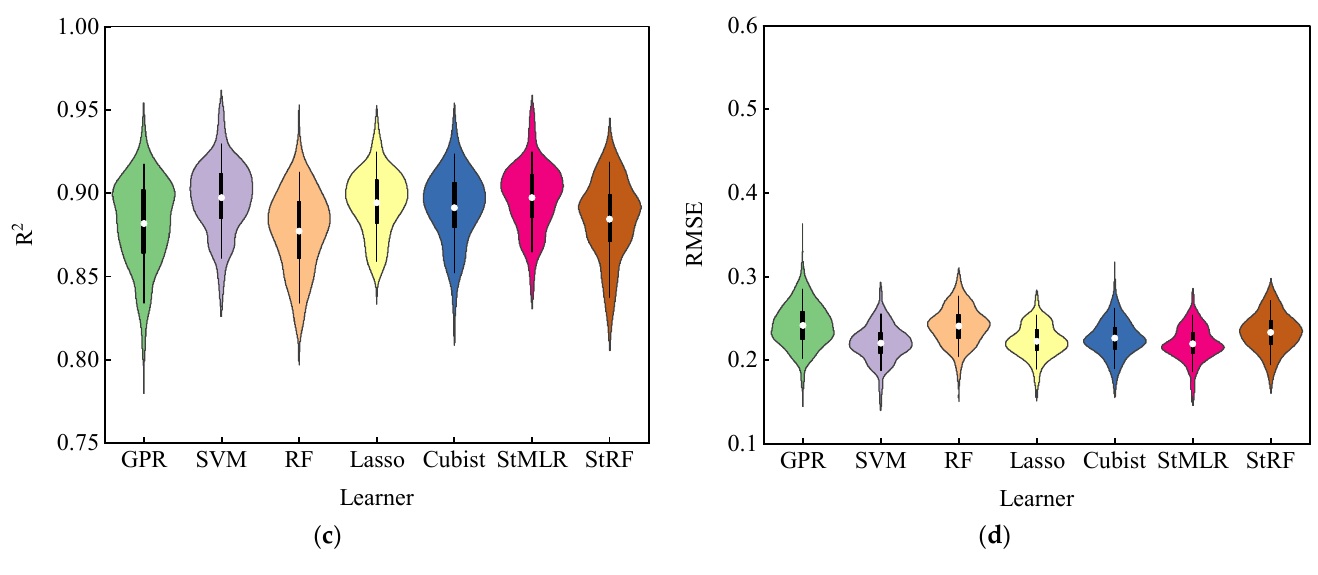
Figure 6. Statistical distribution of the LAI estimation accuracies for all levels of learners during the testing phase. ( a ) Model R 2 in 2020; ( b ) Model RMSE in 2020; ( c ) Model R 2 in 2021; ( d ) Model RMSE in 2021.